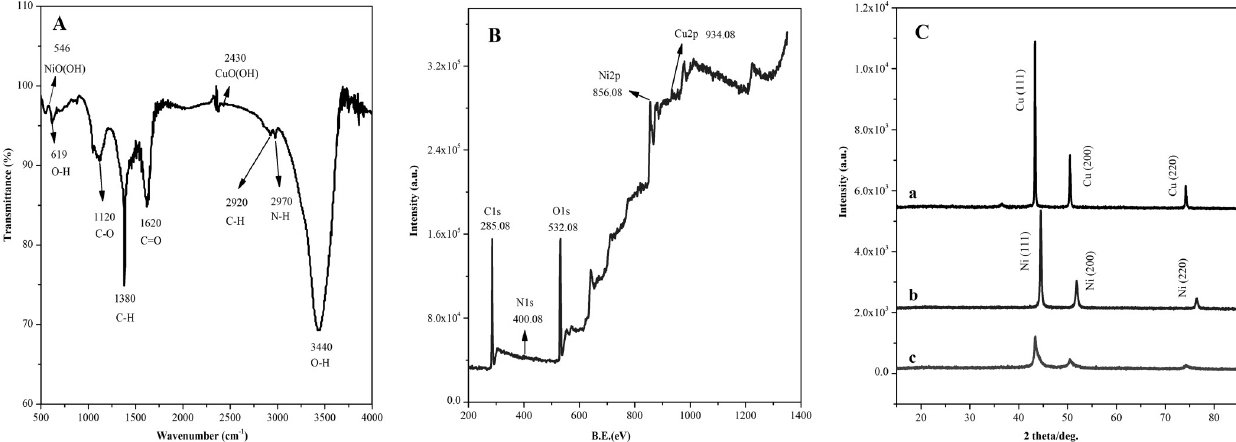
Fig 2. FTIR, XPS and XRD spectra of Cu@Ni CSNPs/N-GQDs NCs. ( A ) FTIR spectrum, ( B ) XPS full spectrum, ( C ) XRD patterns of Cu NPs ( a ), Ni NPs ( b ), Cu@Ni CSNPs/N-GQDs NCs ( c ).